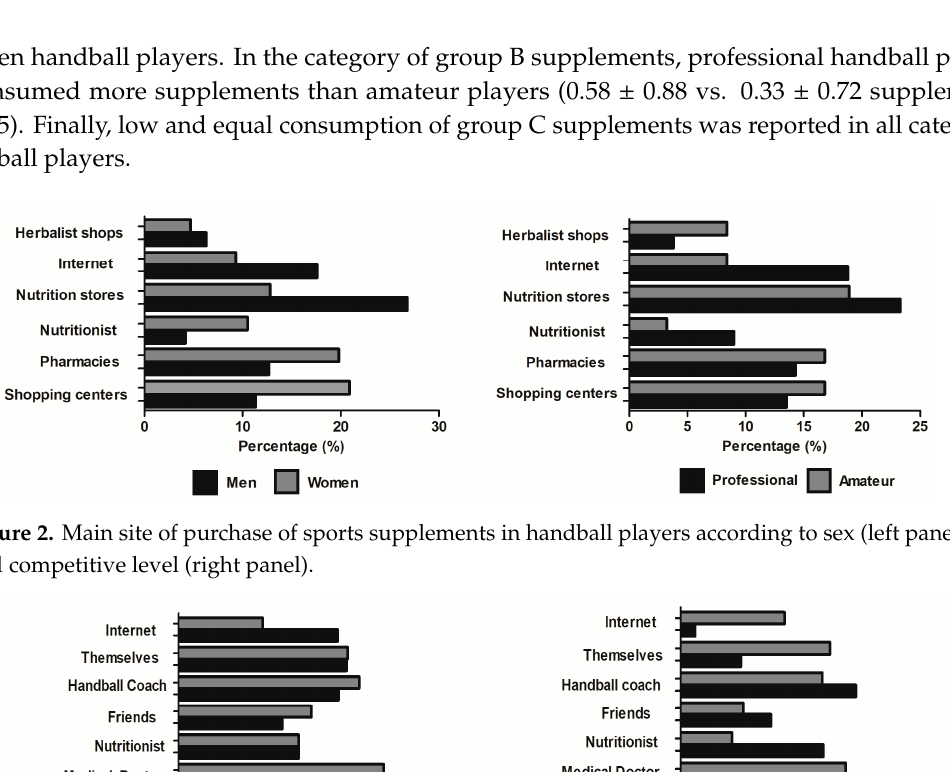
Table 2. Number of supplements used in handball players depending on sex and competitive